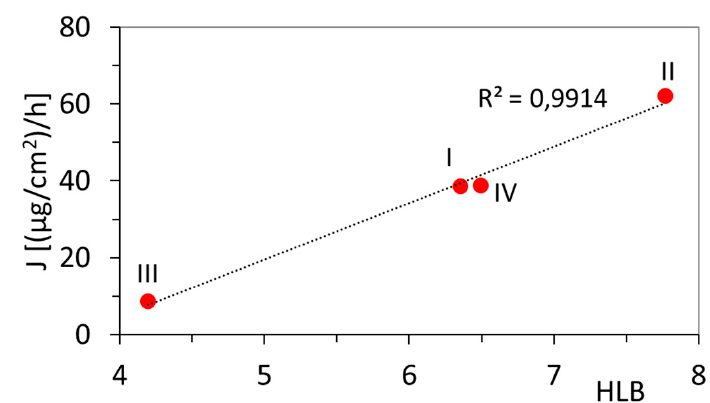
Figure 4. The dependence of the hydrophilic / lipophilic balance (HLB) in graft copolymers on the flow rate through the membrane (J).